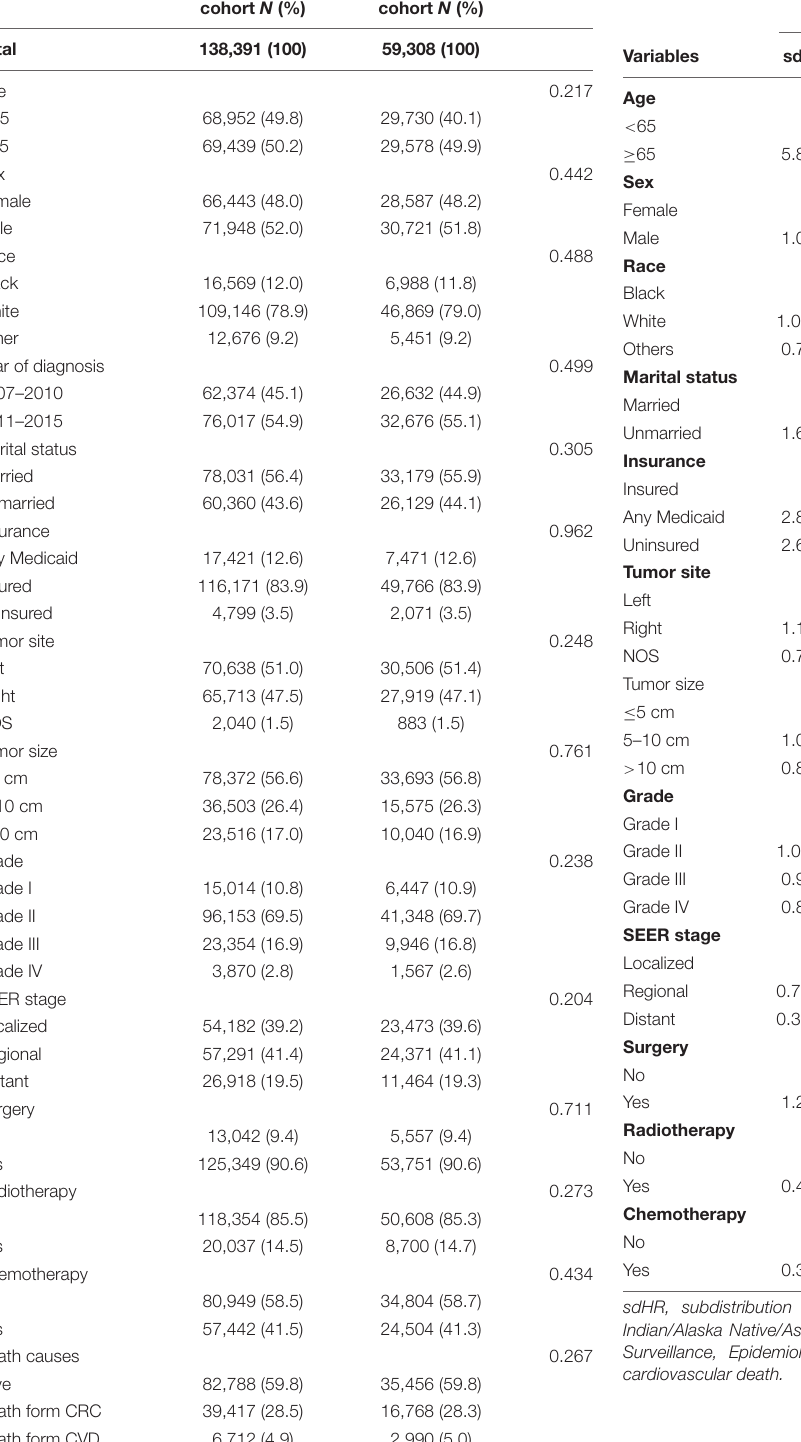
TABLE 3 | Basic characteristics of patients in the training and validation cohorts. Characteristics